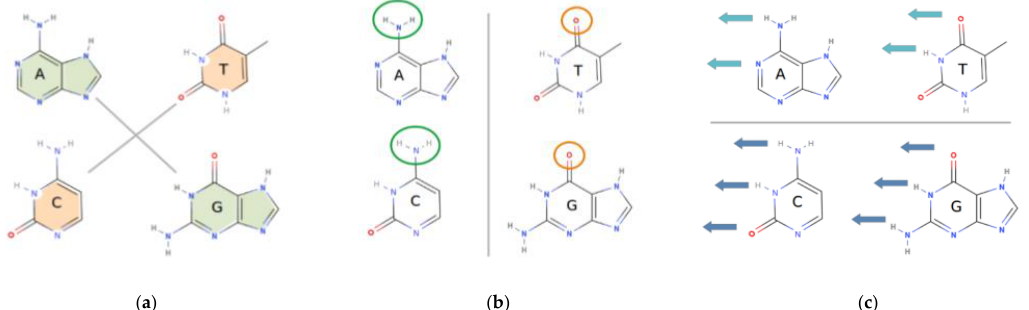
Figure 1. The chemistry behind, and reason for the conversion to binary components. The four DNA bases, A, T, C, and G, each contain distinctive, and yet overlapping chemical and physical properties. This diagram illustrates those properties. It shows the subdivision into three separate categories, which are subsequently used for the binary components analysis. The binary components analysis is about breaking down the information content of the DNA bases into binary parts or components. There is an isolation of targeted chemical and physical properties at the exclusion of other properties. Here, information content of the bases of DNA is isolated into parts so that they can be studied separately. ( a ) The DNA bases contain either a two-ring or one-ring molecular structure. The diagram shows the division into two-ring (green) or one-ring (orange) structures. The two-ring structures are called purines, and A and G are purines (R). The one-ring structures are pyrimidines, C and T and pyrimidines (Y). The presence of purines and pyrimidines in DNA, and the ratios of these in the DNA, will affect the secondary and tertiary local structure of molecules. ( b ) The next category is the chemical property of an amino or keto group. The bases each contain one of these. The diagram shows the amino group (-NH2) circled in green, and the keto group (CO) circled in orange at the relevant position. The bases A and C contain an amino (M) group, whereas G and T contain a keto (K) group. This chemical property affects the hydrogen-bonding capability of the bases, and specifically the hydrogen-bonding donor-acceptor patterns positioned at the major groove of the DNA. These hydrogen-bonding donor-acceptor sites are there for the binding of other particles, such as regulatory proteins to the DNA, during a variety of biological processes. ( c ) The last category is the weak or strong hydrogen-bonding capacity of the DNA bases. This is with reference to the number of hydrogen bonds between the base pairs of the DNA. A and G are weak (W) bases because these contain only two hydrogen bonds between the complementary base pairs, and C and G are strong (S) bases, as these contain three hydrogen bonds between the base pairs. The diagram shows the number of potential hydrogen bonds at the relevant position on each base as blue arrows. The dark blue arrows depict three potential sites, and light blue arrows two potential sites. This property can also influence minor groove hydrogen-bonding patterns. These minor groove sites are for potential binding of other particles to the DNA. In this study, we observe that the KM base classification also reflects another extremely crucial property. This is the hydrogen bond donor-acceptor pattern in the major groove of DNA. Additionally, it is noted that RY is a physical structural property while WS/KM is a chemical property. A conversion of DNA sequences from an ATCG sequence into each of RY, WS, and KM sequences is a breakdown of information content, which isolates one type of property (see Figure 2) [24].